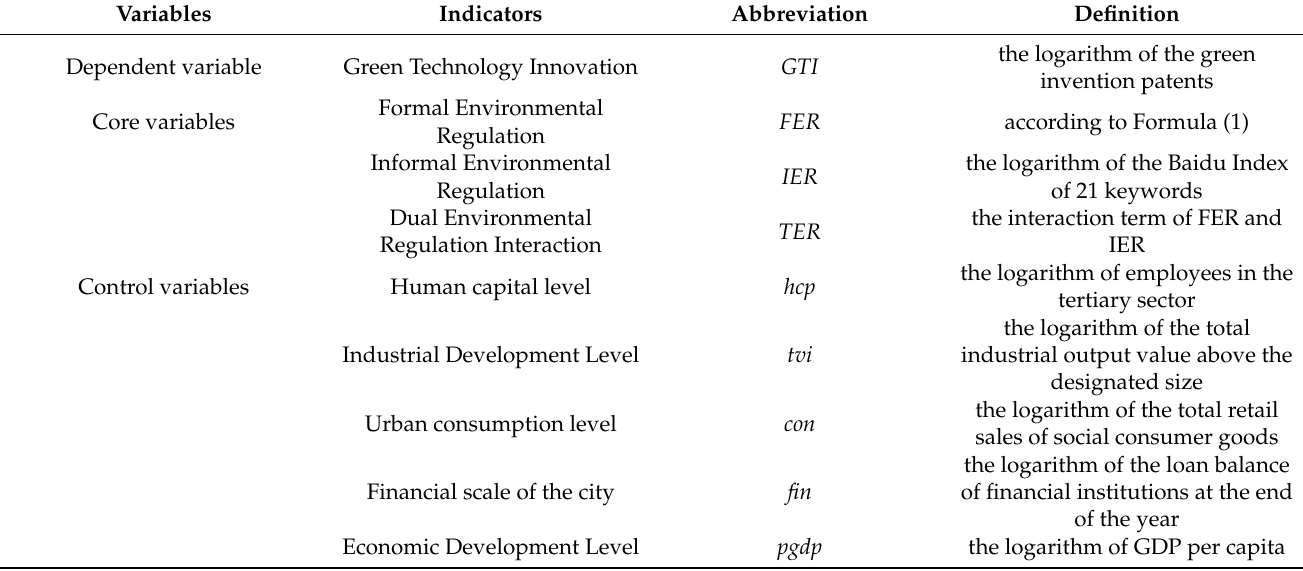
Table 1. Definitions of